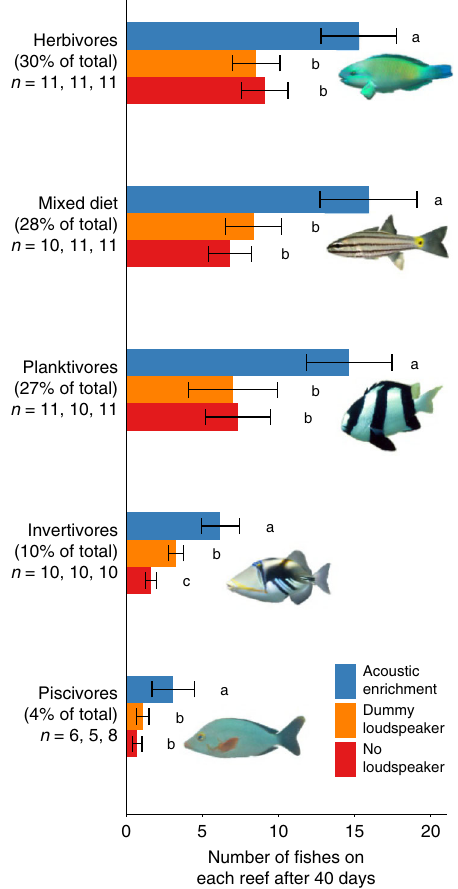
Fig. 2 Effects of acoustic enrichment on different trophic groups. Mean ± SE juvenile fi sh abundance in different trophic guilds on experimental patch reefs. Y -axis labels give the proportion of all fi shes and the frequency of occurrence (number of populated reefs in each loudspeaker treatment) represented by each trophic guild. Mixed-effects models revealed signi fi cant effects of loudspeaker treatment in all fi ve trophic guilds; different letters associated with boxplots represent signi fi cant differences in post-hoc Tukey ’ s HSD tests (Supplementary Table 1). Images of fi sh are taken from the Lizard Island Field Guide